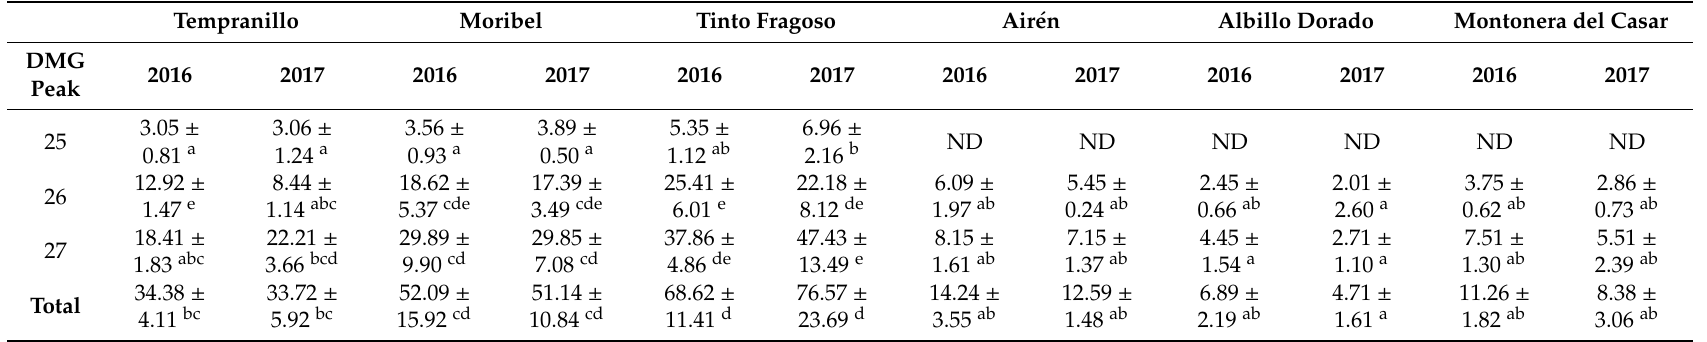
Table 3. Individual and total dimeric flavanol monoglycosides (DMG) of skin extracts from Vitis vinifera grape varieties, expressed as µ g / kg grape FW (mean value ± standard deviation, n =